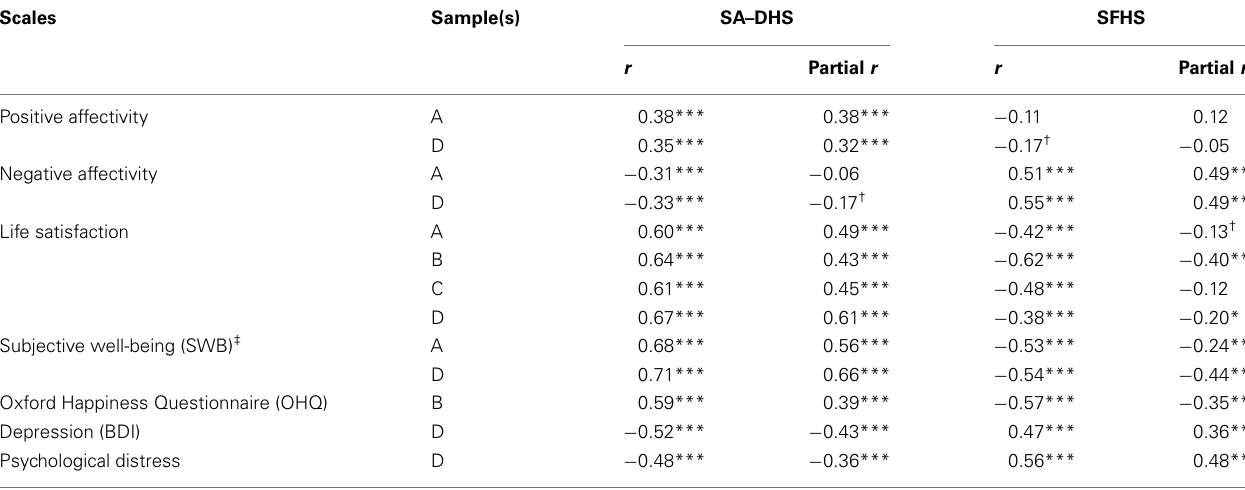
Table 3 | Correlations of the SubjectiveAuthentic–Durable Happiness Scale and the Subjective Fluctuating Happiness Scale with various measures of well-being, happiness, and mental